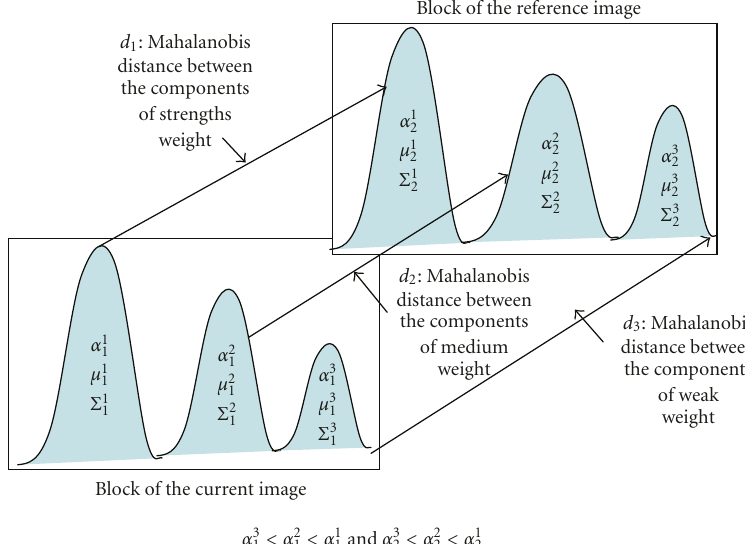
Figure 3: Extended Mahalanobis distance between the components of strong weights ( d 1 ), the components of medium weights ( d 2 ), and the components of weak weights ( d 3 ).